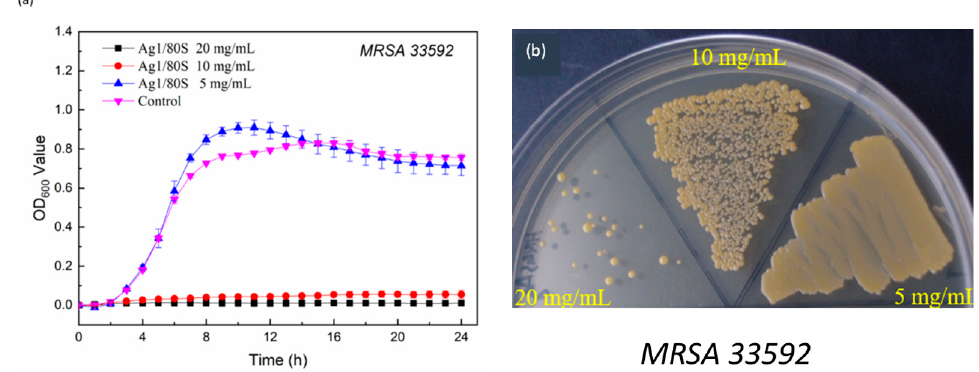
Figure 9. Microbiological assay of Ag1/80S against MRSA (ATCC 33592); ( a ) kinetics curves of microbial growth; and ( b ) colony-forming capacity assay.